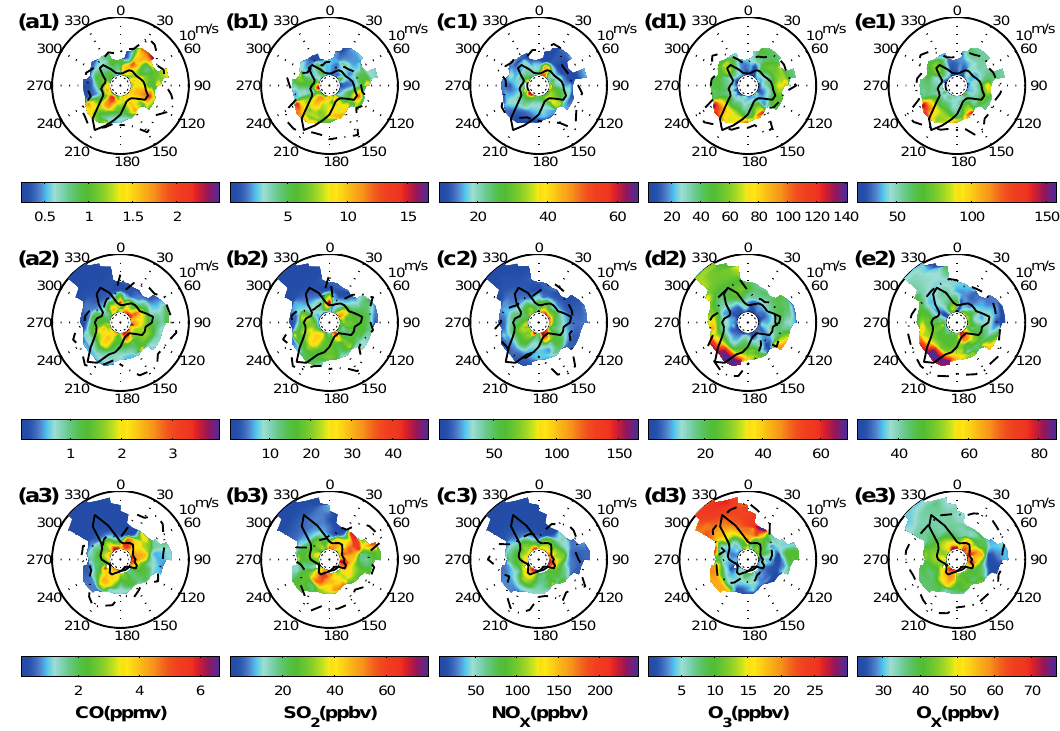
Fig. 7. Wind Dependency map of CO (a) , SO 2 (b) , NO x (c) , O 3 (d) and O x (e) mixing ratio for summer (1), fall (2) and winter (3). Wind speeds are shown from 0 to 10ms − 1 (radial distance). The dashed black line shows relative mean gas concentration, while the solid black line is the relative frequency of occurrence versus wind direction both on a scale of 0 to